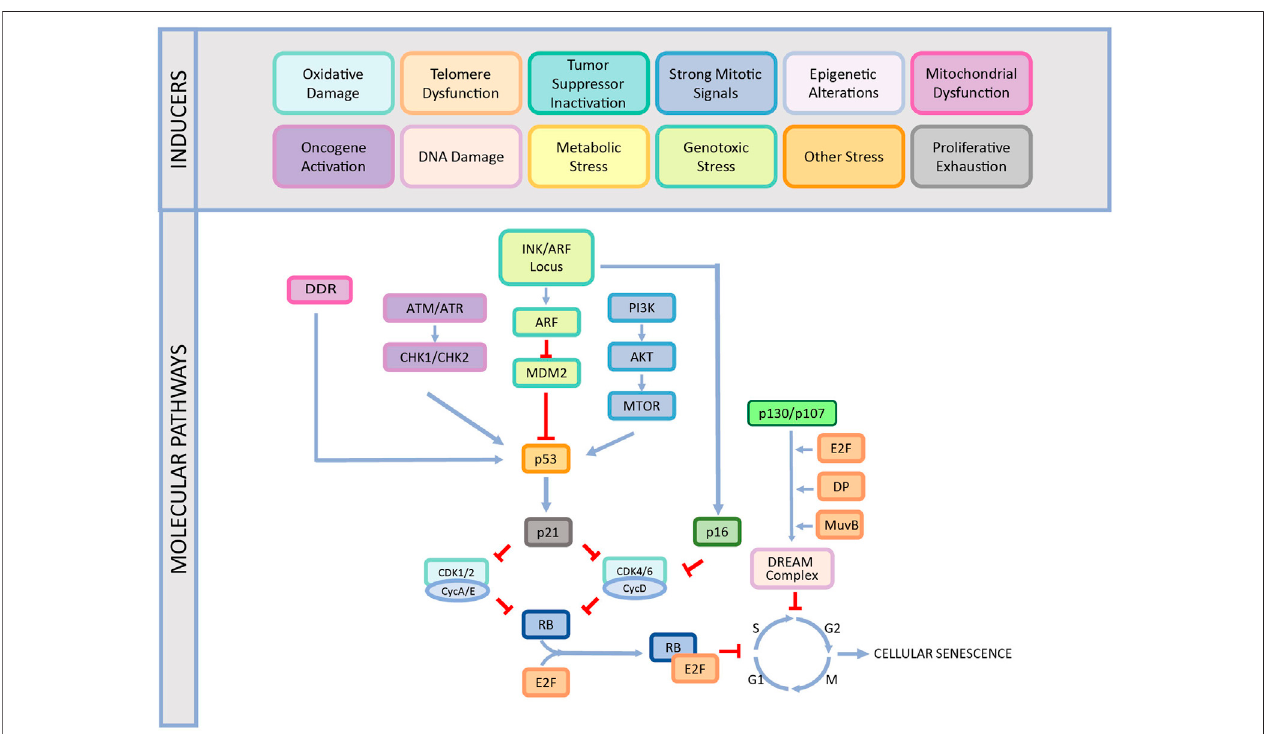
FIGURE 1 | The causes and different mechanisms involved in cellular senescence. CS is induced by various factors such as oxidative damage, telomere dysfunction, tumor suppressor inactivation, strong mitogenic signals, epigenetic alterations, mitochondrial dysfunction, oncogene activation, DNA damage, proliferative exhaustion, metabolic stress, genotoxic stress, and other stress. This induction occurs by different pathways and ends up with stable cell cycle arrest. This fi gure is created by BioRender.com.